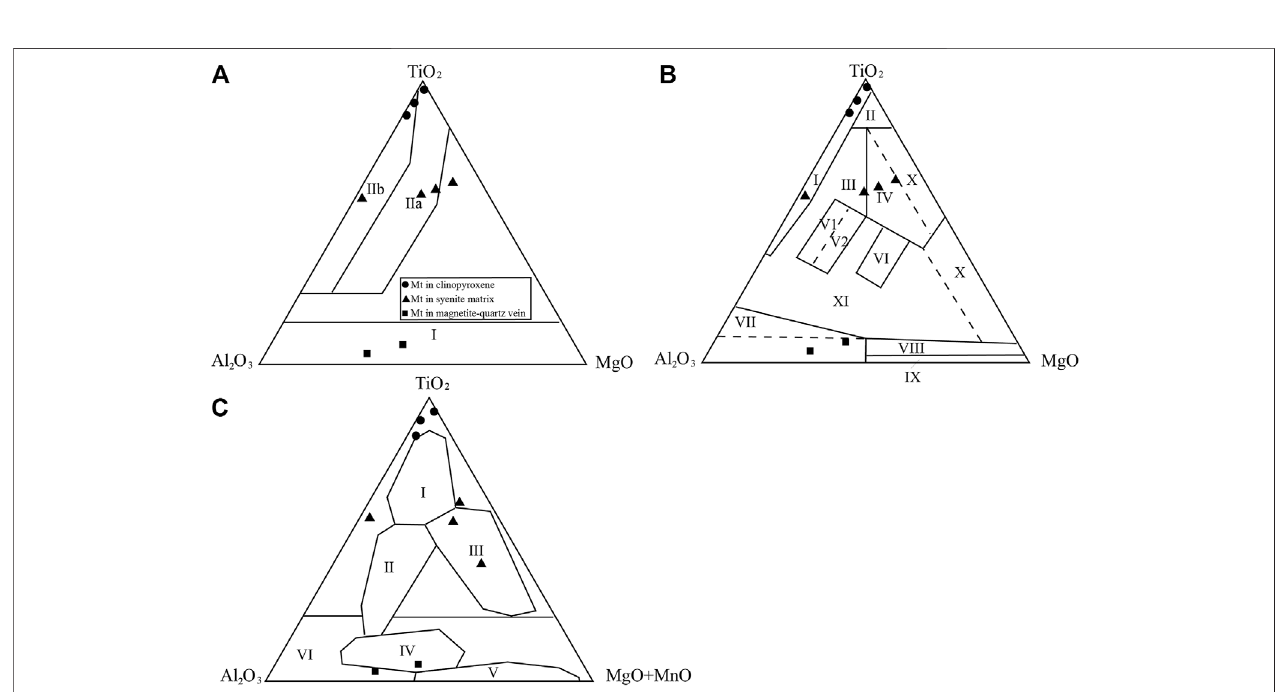
FIGURE 9 | Genetic diagram of magnetite: (A) I. sedimentary metamorphism-contact metasomatic magnetite, IIa. ultrabasic – basic – neutral magmatic magnetite, IIb, acid – alkaline magmatic magnetite (based on Chen et al., 1987); (B) I – VI. Magma type, VII. Hydrothermal and calcic skarn type (hydrothermal type under dash line, calcic type below dash line); (C) I. Accessory mineral type, II. Magma immiscible separation titanium magnetite type, III. Volcanic type, IV. Hydrothermal type, V. Skarn type, VI. Metasendimentary (based on Chen et al., 1987).